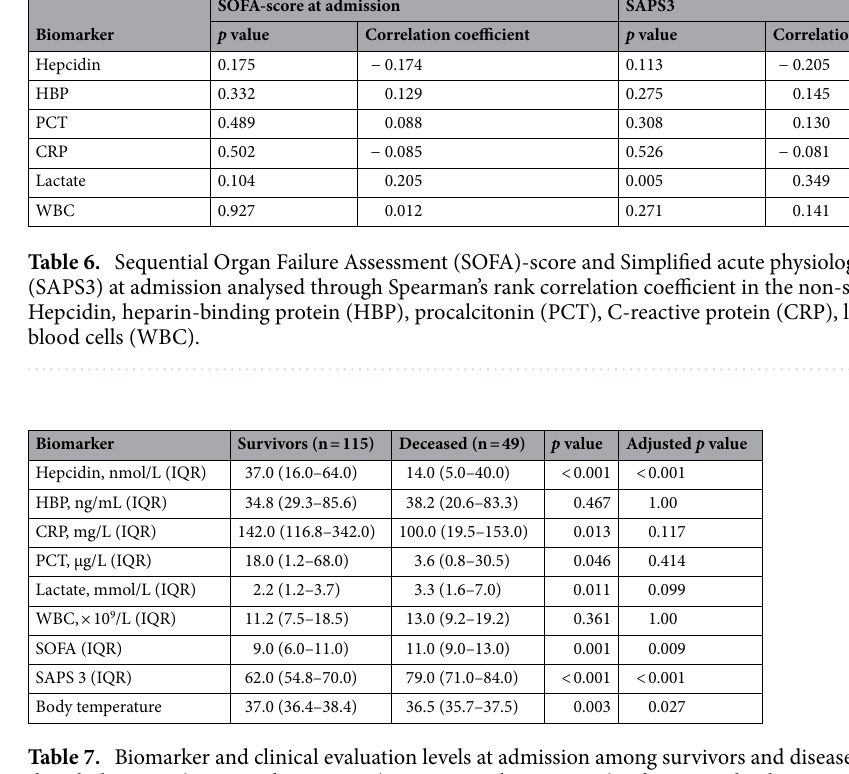
Table 7. Biomarker and clinical evaluation levels at admission among survivors and diseased at 180-days for the whole group (sepsis and non-sepsis). Mann U Whitney test. (In the septic shock group, 24/100 patients had deceased at 180-days and in the non-sepsis group, 25/64 patients had deceased at 180-days). Bonferroni corrected p value for 9 comparisons.